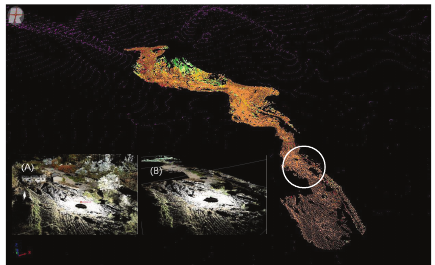
Figure 6: The capture of combined cloud points: original LiDAR range image subjected to debris flow (A) and cutting result of forest canopies and artificial structures